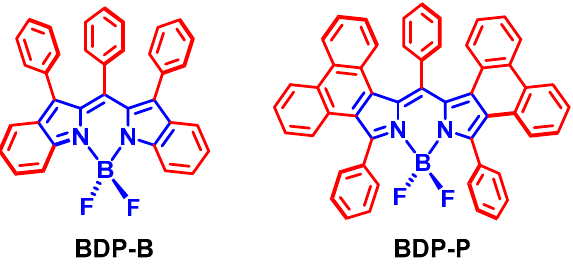
Figure 11. Bodipy derivatives showing that the ISC quantum yields are not directly correlated with the torsion of the π -conjugation system.